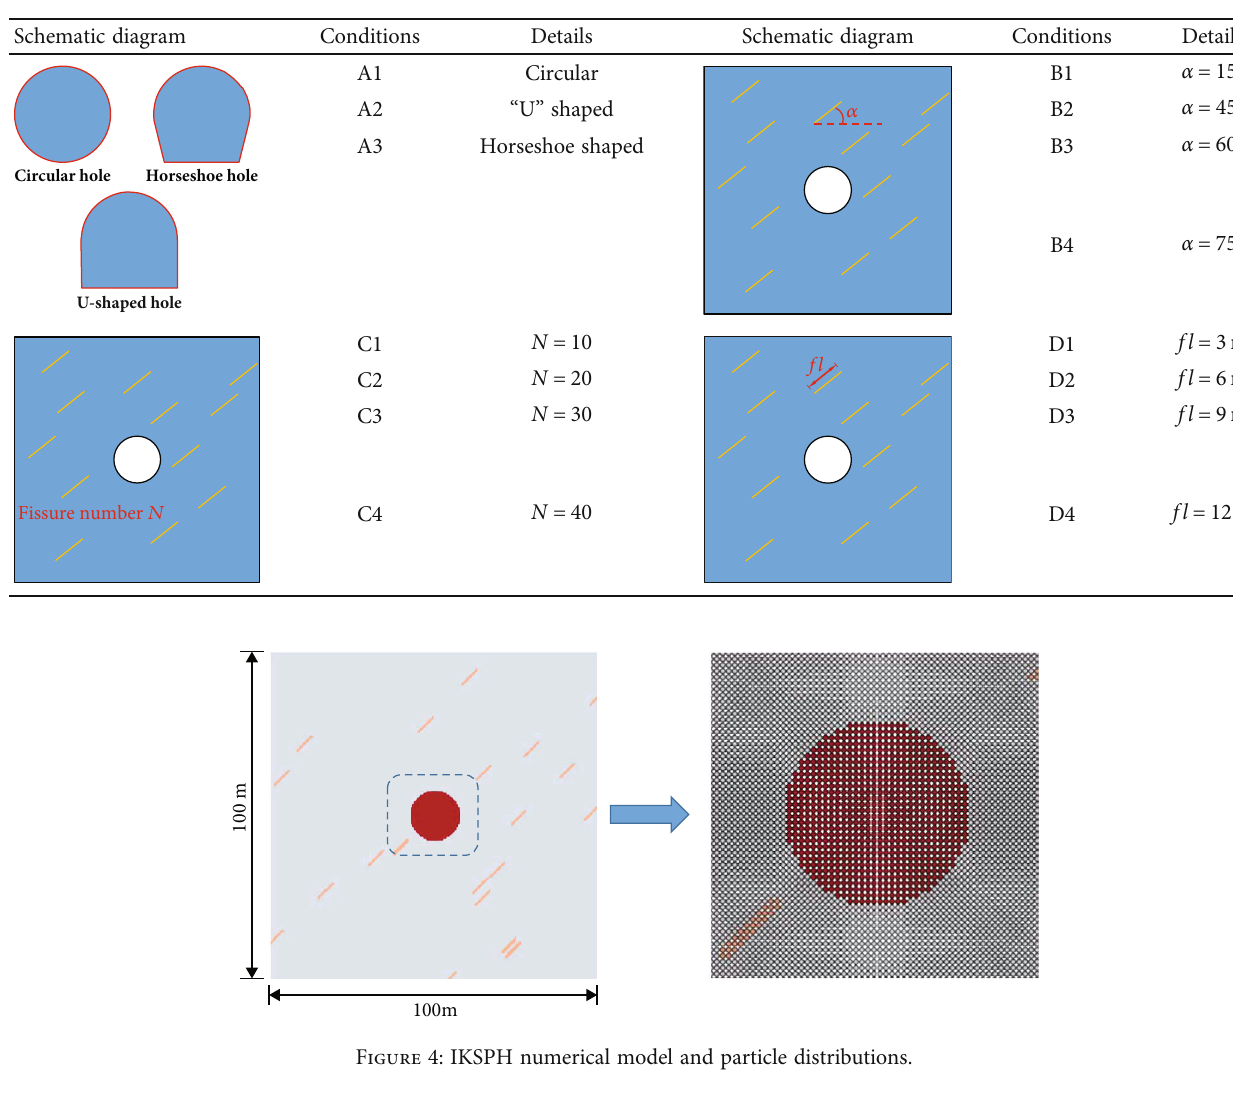
Table 2: Calculation conditions.